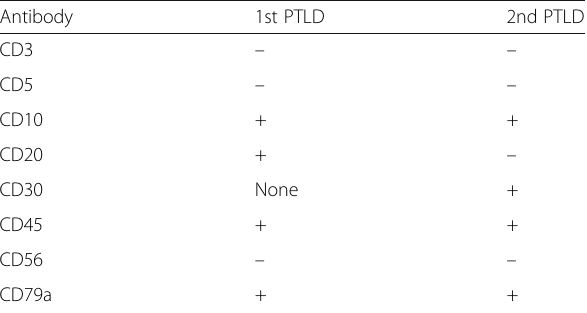
Table 1 Immunohistochemical findings of each post-transplant lymphoproliferative disorder (PTLD)